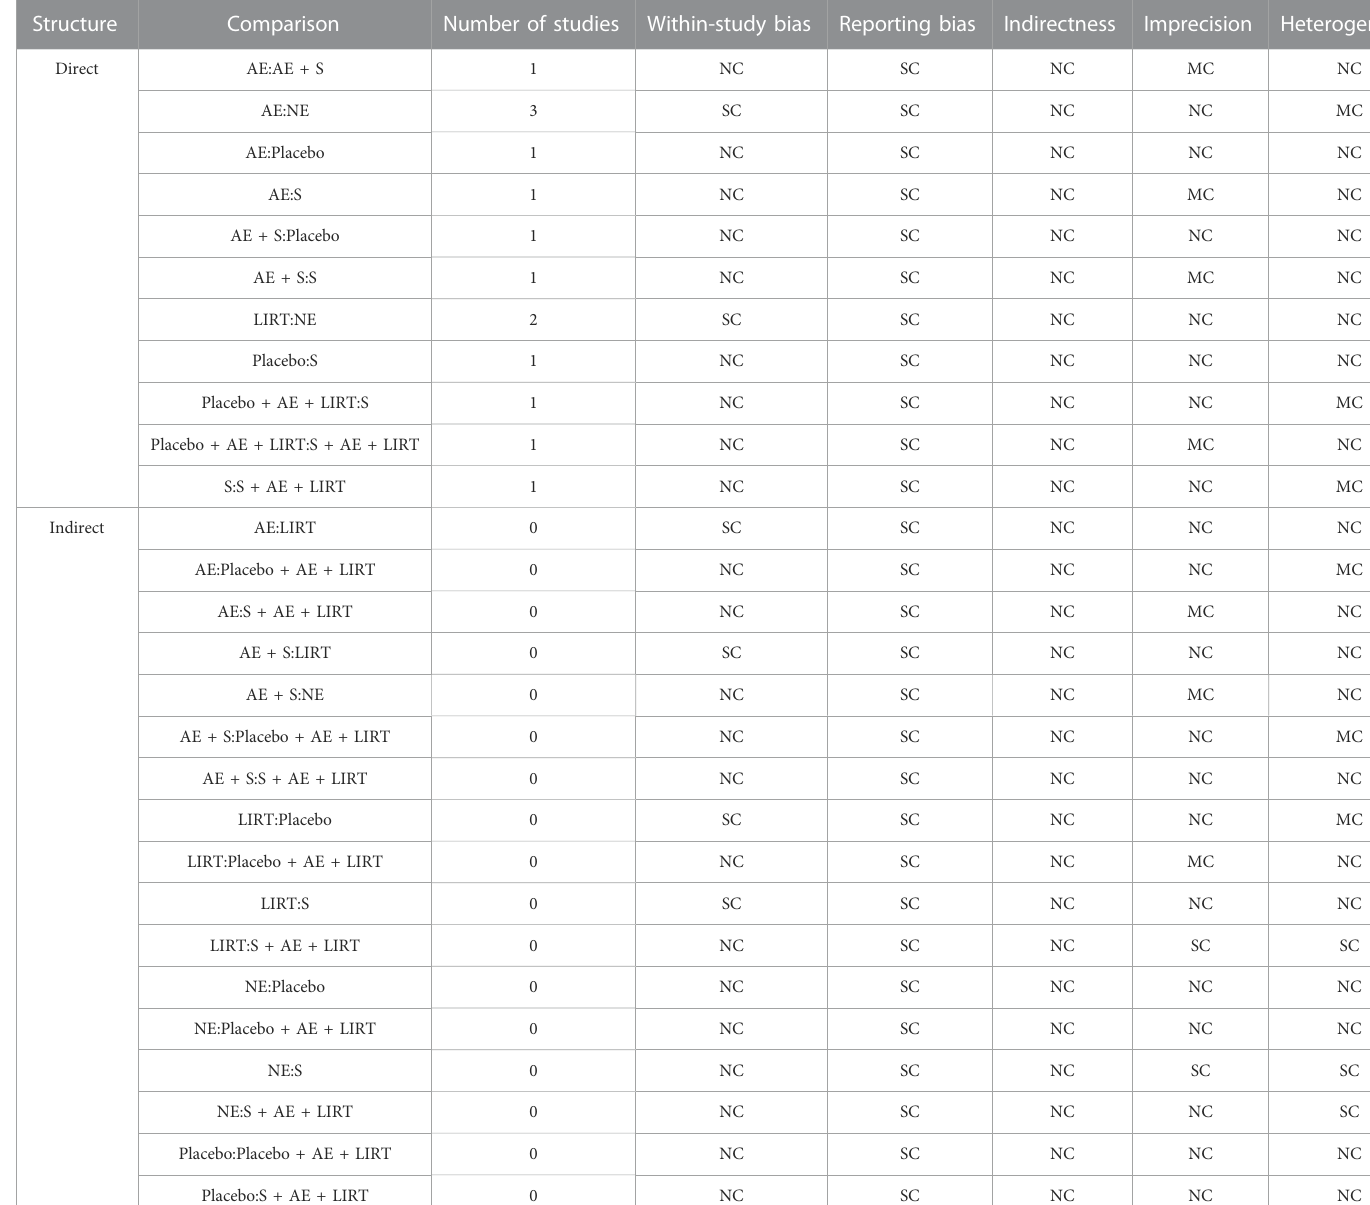
TABLE 5 Results of the con fi dence rating.